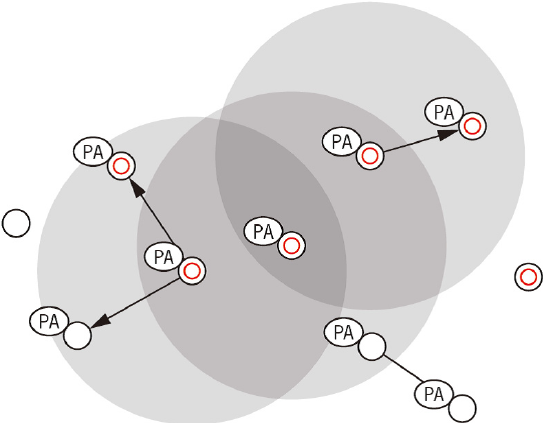
Fig. 17. PAs keep cloning to ¯nd the